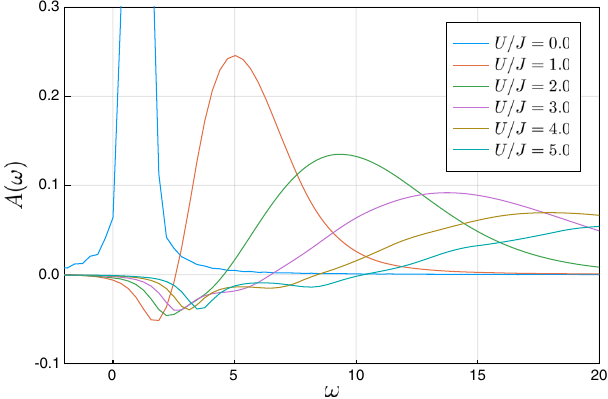
FIG. 14. Local spectral function A ð ω Þ for increasing values of the Kerr nonlinearity U , at a fixed value of hopping J ¼ ω 0 and drive-to-loss ratio r ¼ 3 within DMFT NCA. We see that the frequency Ω 0 at which the density of states vanishes decreases with U and eventually disappears for small enough values of U . 14 . Parameters: z ¼ 6 and dim H ¼